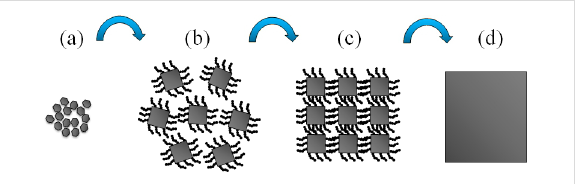
Figure 1: Schematic of the oriented attachment process that occurs in the presence of organic additives. (a) Nuclei grow into primary building blocks, which are displayed in (b). These primary building blocks reor- ganize and form a mesocrystal (c). The primary building blocks fuse at specific crystallographic faces and form a secondary nanoparticle, which is displayed in